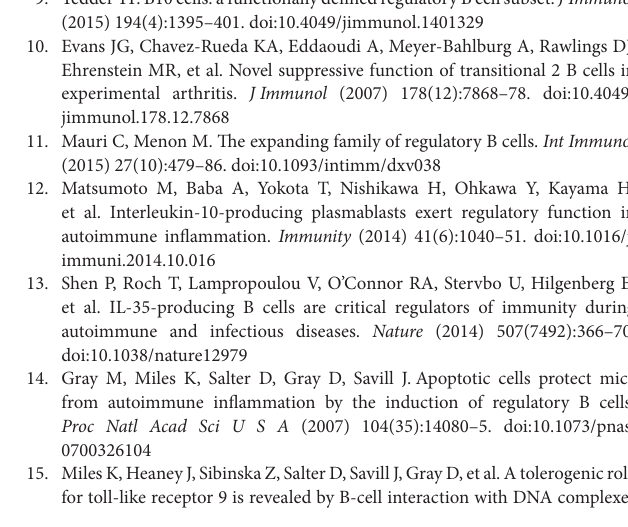
FigUre s3 | (a) Representative dot plots showing interaction of B cells and apoptotic cells (i) showing splenic follicular B cells on left and peritoneal cavity B1a cells on right. Upper plots show 4 h culture, lower 24 h culture. Single color control images for microscopy staining shown in Figure 3a , ii, can be seen in [ (a) , ii]. Scale bar represents 20 μ m. (B) Histogram plots for surface markers of IL-10 + ve B cells (in red), used to generate hybridomas in Figure 3D , compared to IL-10 − ve B cells (in black) and isotype control (in shaded gray). (c) Schematic representation of hybridoma generating process. (D) Supernatants from hybridoma clones ( Figure 3D ) and subsequent pooled supernatants used in Figure 4a were incubated with apoptotic cells. Binding could be seen in IL-10 + ve sups (dashed line) but not IL-10 − ve sups (solid lines) to jurkats (i) and thymocytes (ii) but not viable jurkats (iii). FigUre s4 | (a) Supernatants used in Figure 4a showed no binding to viable jurkats. Cell membrane red, IgM green, DAPI blue. Scale bar represents 20 μ m. (B) Single stained controls for Figure 4a showing single cell mask plasma membrane dye in red, IgM staining in green, and DAPI in blue. Scale bar represents 60 μ